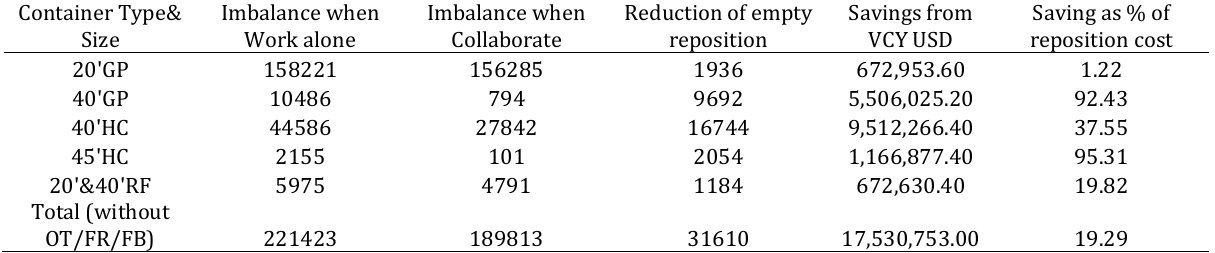
Table 5: Benefits of exchange and savings for major types of containers- 2013 Port of Colombo Container